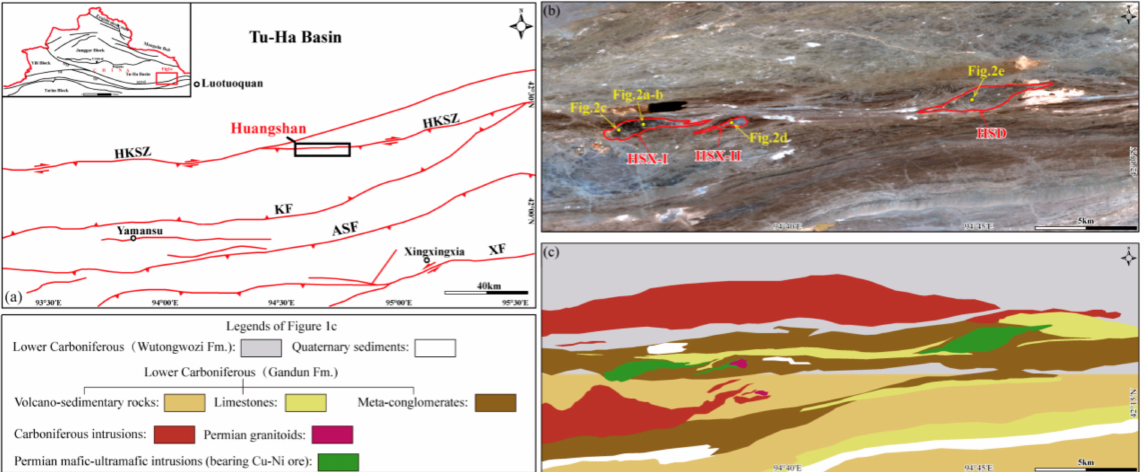
Figure 1. The tectonics map in the eastern Tian Shan and the surrounding area ( a ), a GF-1 true color image showing the locations of field photographs in Figure 2, ( b ) and the geological map of Huangshan ore belt ( c ) [42,43]. ASF: Aqikkuduk- Shanquanzi Fault; HKSZ: Huangshan-Kanggur Shear Zone; KF: Kushui Fault; MTSZ: Main Tian Shan Shear Zone; NF: Nalati Fault; NTF: North Tian Shan Fault; QF: Qingbulake Fault; XF: Xingxingxia